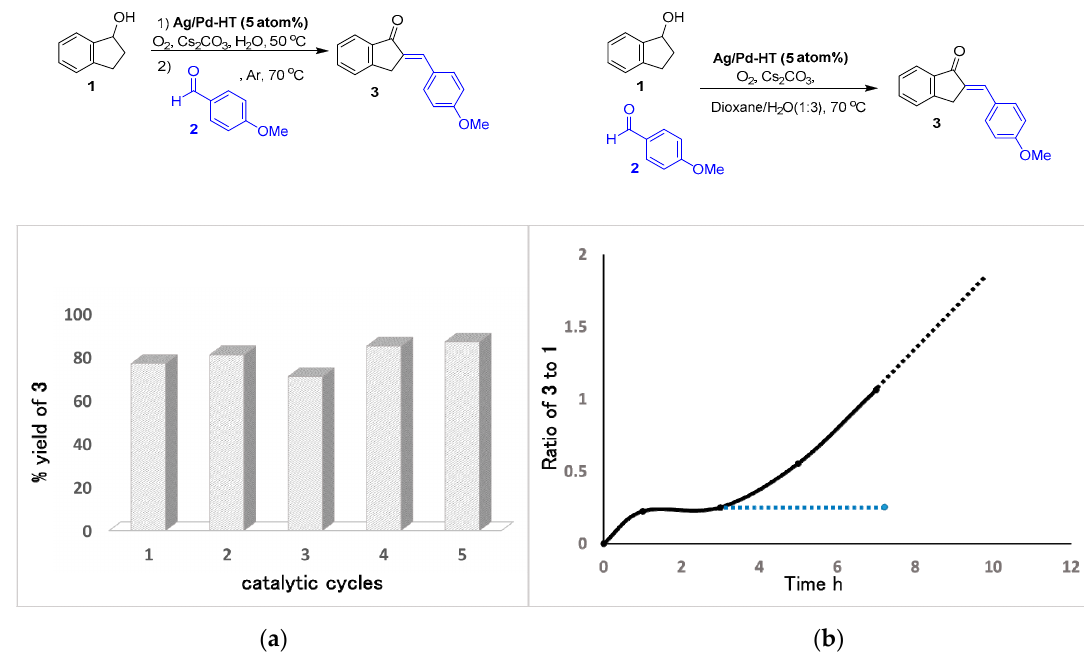
Figure 2. ( a ) Reusability test of (1:1) Ag/Pd-HT in oxidative coupling of 1-indanol with 4-methoxybenzaldehyde and ( b ) time-course study and hot filtration test for the (1:1) Ag/Pd-HT catalyzed oxidation of